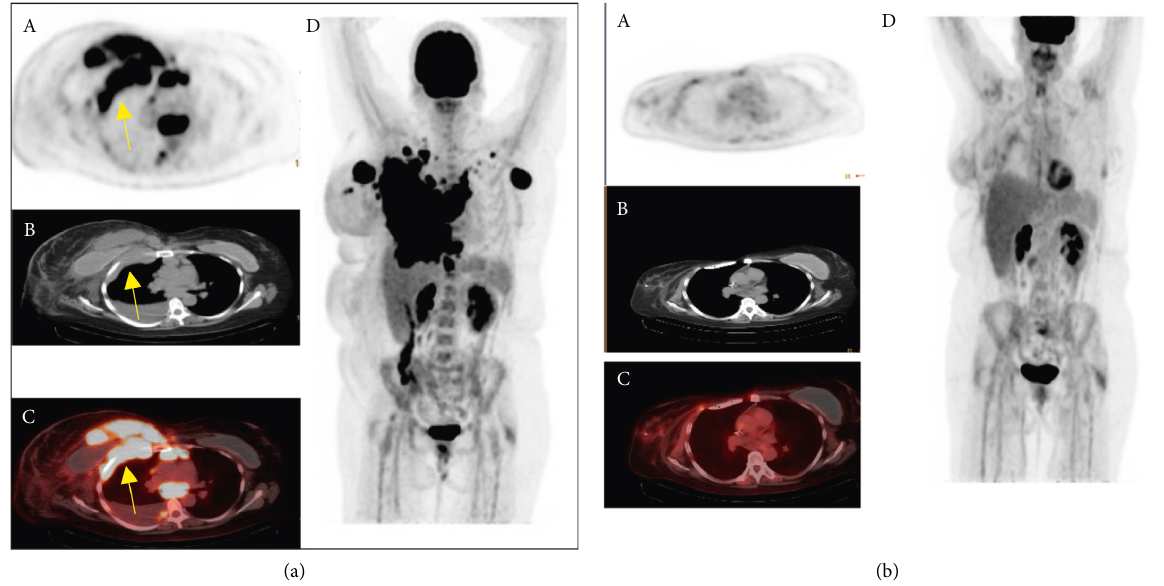
Figure 2: (a) Baseline: (A) axial PET, (B) CT, and (C) fused images from an FDG-PET/CTscan performed at baseline demonstrate a large, infiltrative mass in the right chest wall measuring approximately 13x10x20 cm. The mass spans the subcutaneous, muscular, and chest wall compartments with extension into the pleural/extrapleural compartments (arrows). (D) A maximum intensity projection (MIP) image shows the large extent of disease. (b) Post treatment: (A) Axial PETafter treatment with 6 cycles of CHP/BV, Surgery and XRT, (B) CT, and (C) fused images with stable postsurgical changes showing (d) overall significant positive response with slight interval increase in interstitial opacity in the central right breast with low-grade FDG uptake thought to be related to inflammation post